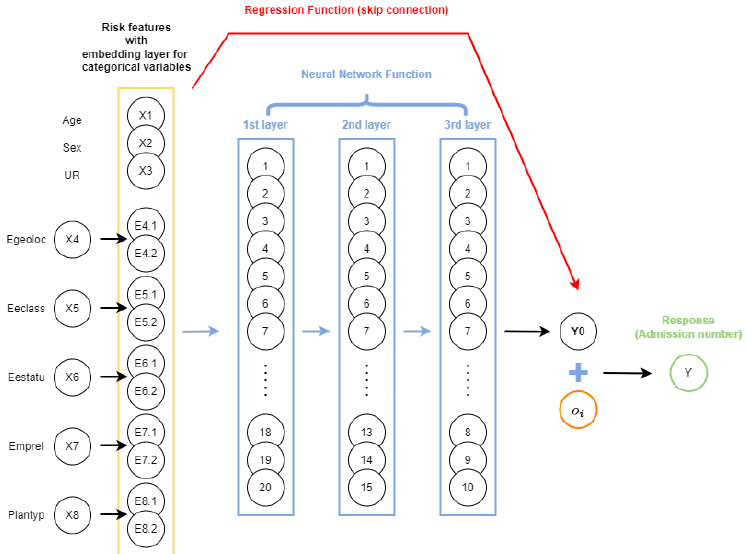
Figure 5. An illustration of a sample CANN model with three hidden layers and 20,15,10 neurons in each